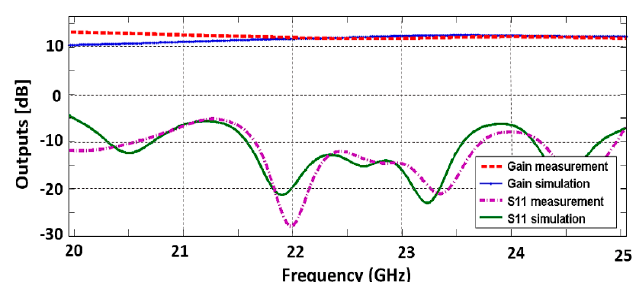
Figure 15. Vivaldi antenna array with three-way in-phase SIW power divider feed system.